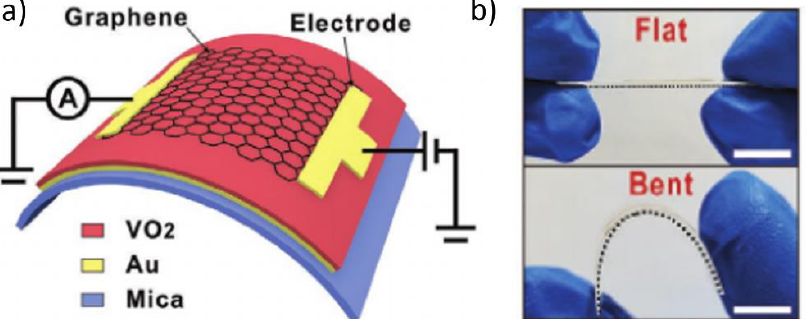
Figure 3. ( a ) Schematic representation of a flexible and electrically tuned flexible phase change material (FPCM) structure; ( b ) Mechanical flexibility of FPCM with 10 mm scale bars. Reproduced with permission from [91]. Copyright 2021, Wiley.